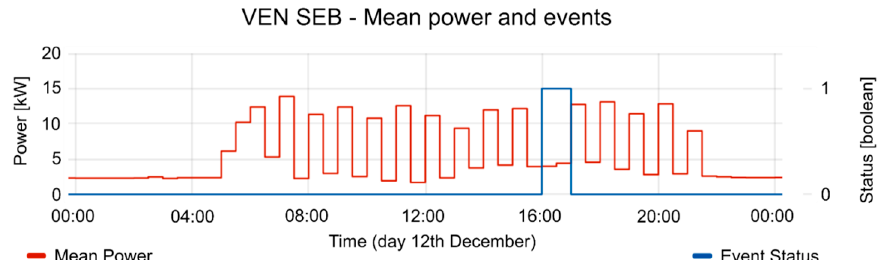
Figure 19. Mean Power and event status (where 1 is active and 0 is inactive) for 12 December test.